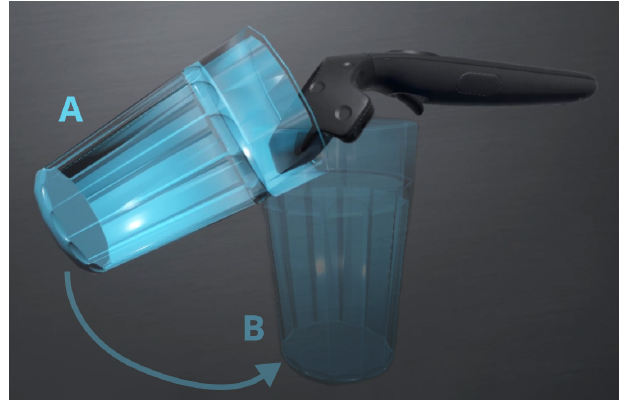
Figure 11. Illustration of grip adjustment. The glass is held with firm grip (a). Then, the user loosens the grip by releasing the trigger half-way: The glass swings downwards according to gravity (b). The position of the controller does not